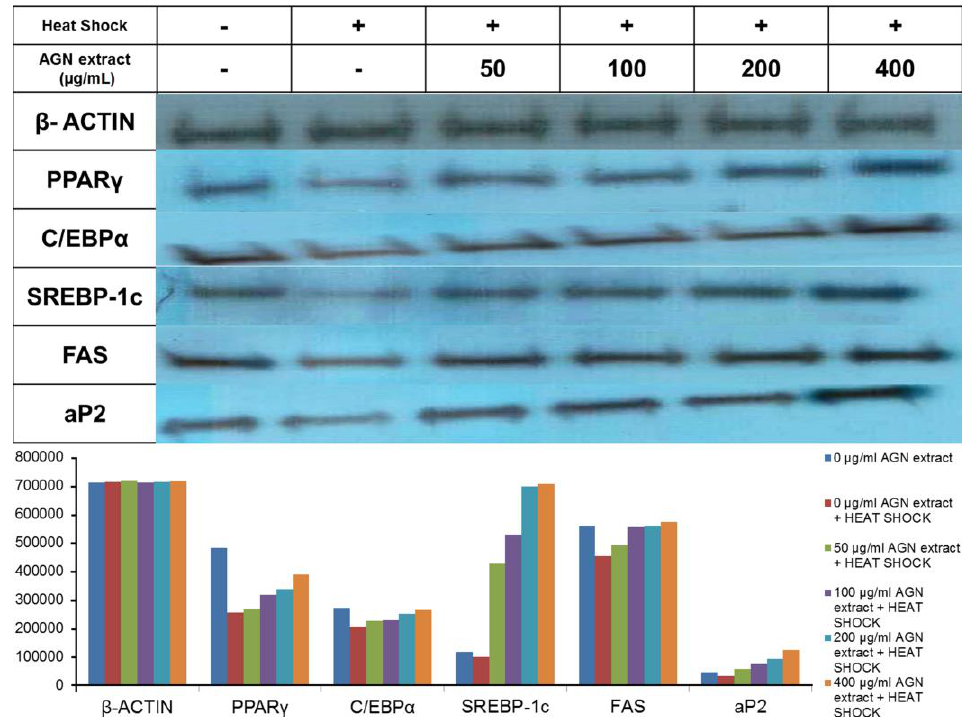
Figure 7. Protein expressions with densitometry measurements of adipogenic markers in the differentiated murine 3T3-L1 after heat shock procedure at G0 stage; recovery and then treatment with Angelica gigas Nakai root hot water extract (0, 50, 100, 200, and 400 μg/mL) prior to differentiation